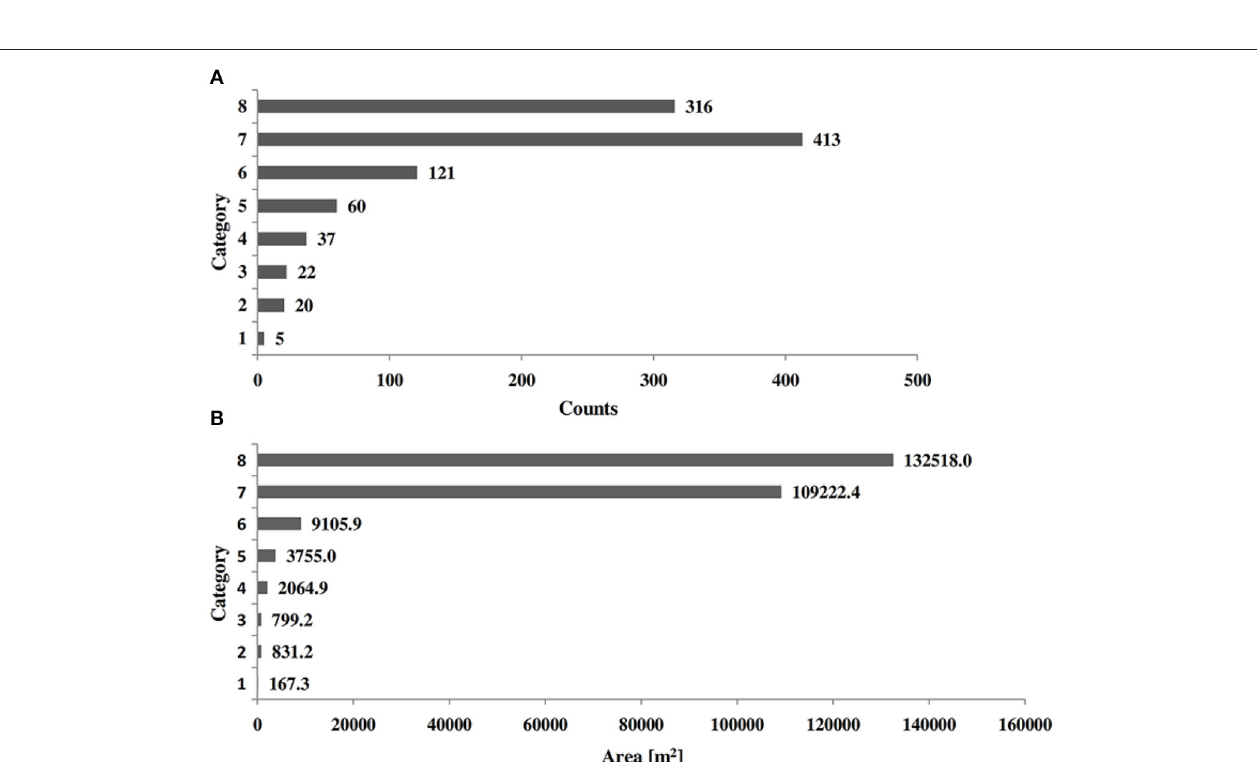
FIGURE 8 | (A) Histograms of building polygon counts with corresponding categories for solar energy potential. (B) Histograms of rooftop polygon area within corresponding categories for solar energy potential.